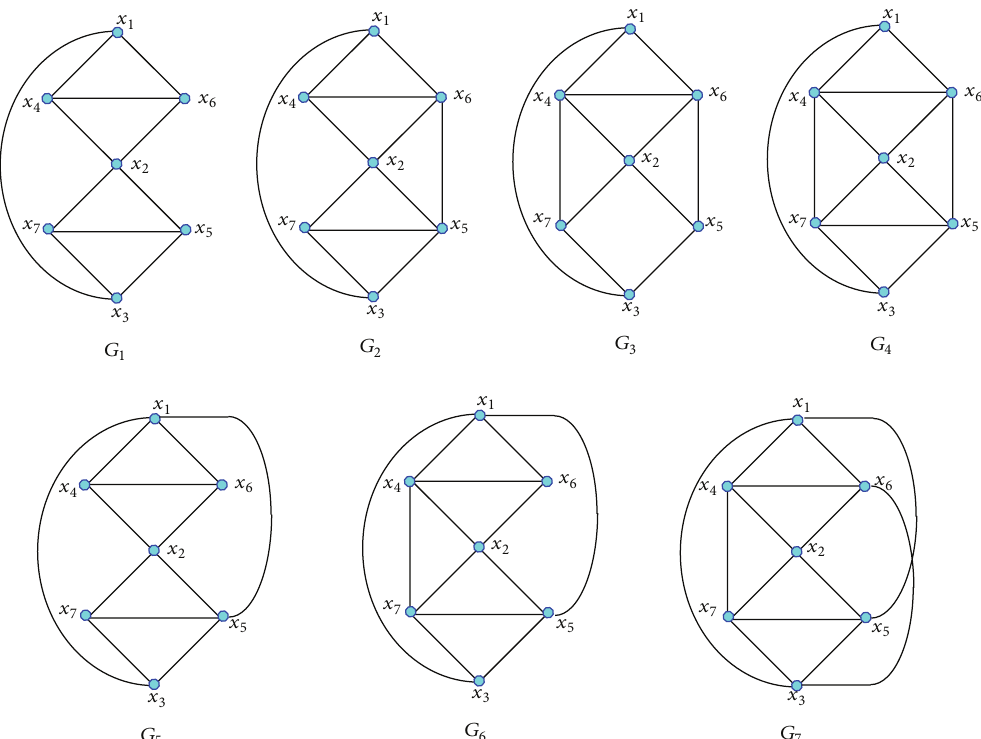
Figure 2: The 7-vertex graph with chromatic number 4 and having no 𝐾 4 and 𝐶 5 ∨ 𝐾 1